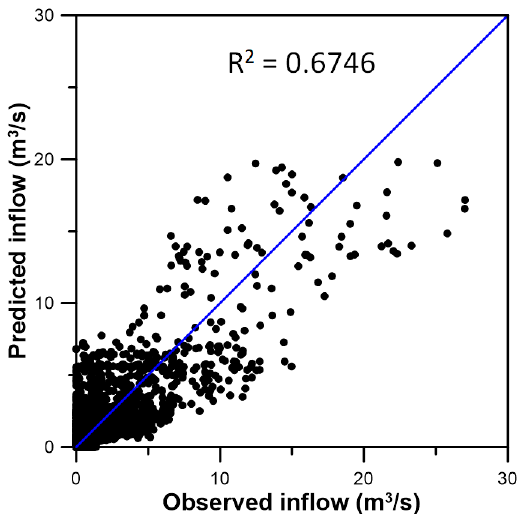
Figure 8. Comparison of R 2 for observed and predicted in fl ows when using Adam.